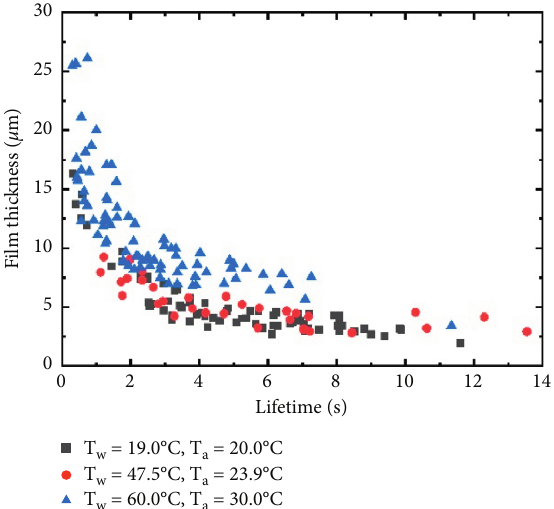
Figure 14: Correspondence of cap film thicknesses and bubble lifetimes at different liquid temperature.